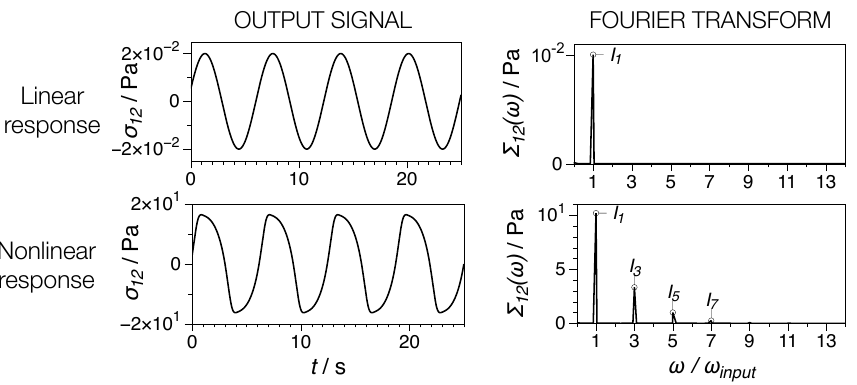
Figure 2. Generic principle of Fourier transform rheology showing time-dependent linear and nonlinear stress material response to a sinusoidal strain input and corresponding Fourier transform of the output signal showing the presence of higher harmonics in the nonlinear case.